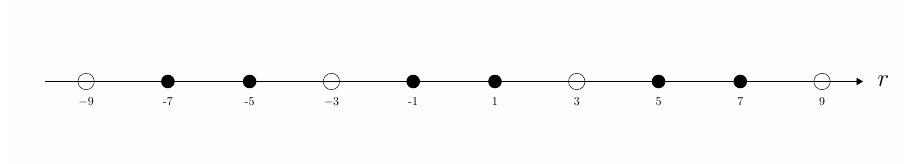
Figure 3 . The r lattice of local P 2